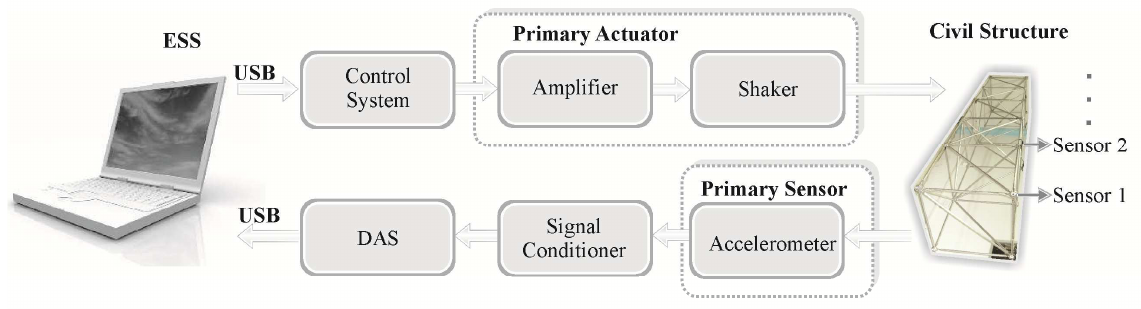
Fig. 2. Proposed methodology flow diagram.